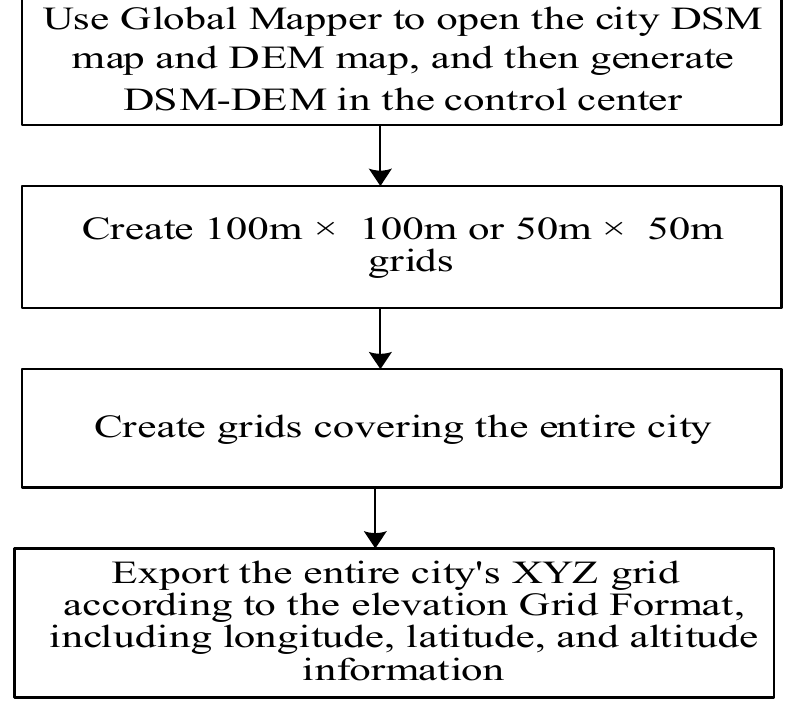
Figure 4. A process using DSM–DEM to extract urban roughness.